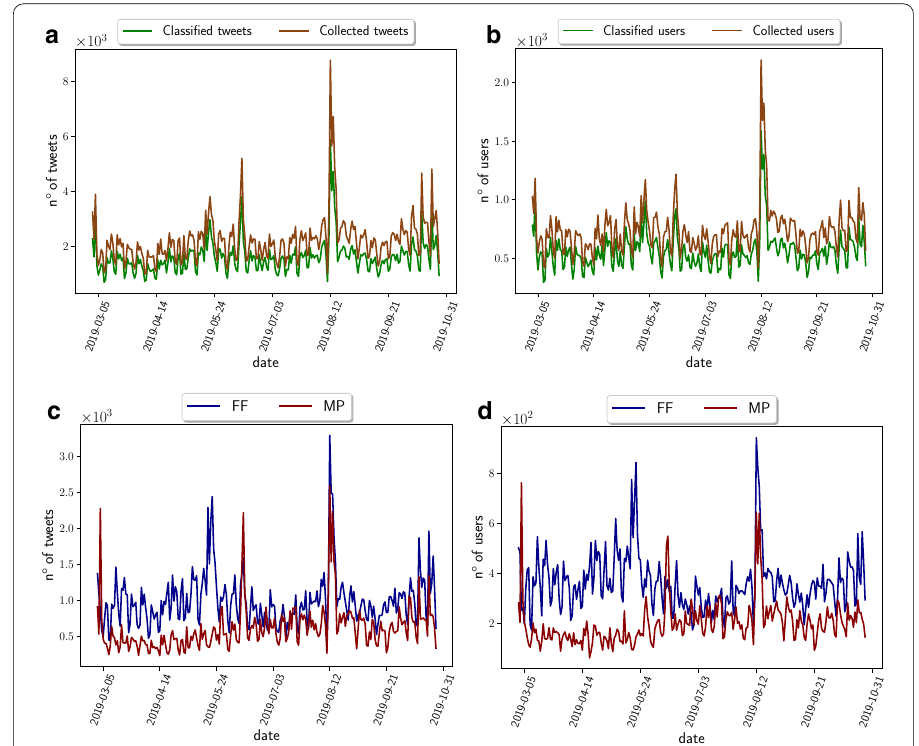
Fig. 6 Bots analysis: we detect bots with methods from [18] and classify them according to bots favorable to FF or MP. a Daily volume of collected (brown line) and classified (green line) tweets from bots. b Daily volume of collected (brown line) and classified (green line) bots. c Daily tweets from bots supporting the FF or MP formula. d Daily bots supporting the FF or MP